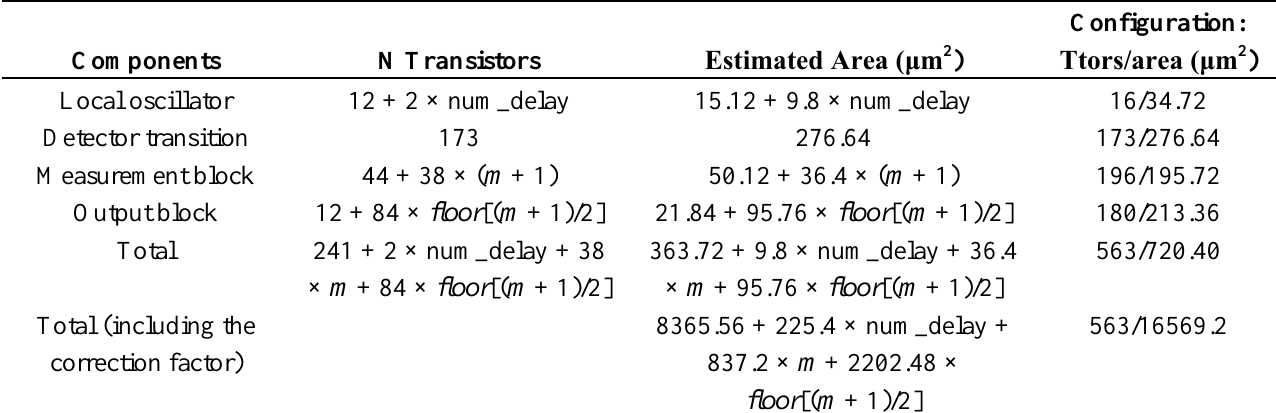
Table 1. Estimation of hardware resources depending on the configuration of the VLSI